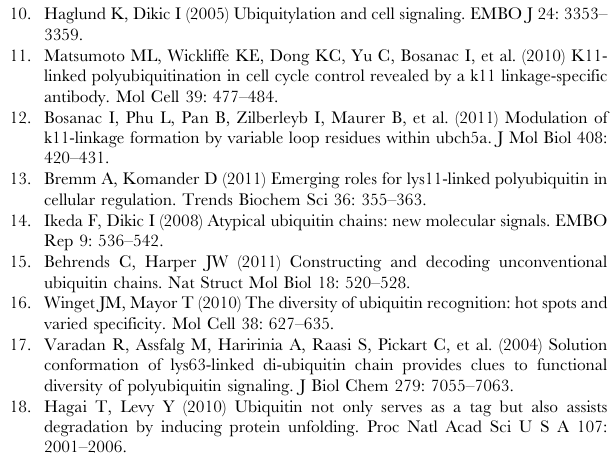
linked diUbs. Figure S12 Conformational distribution of K63-diUb based on the order parameter similar to smFRET measurement. It is difficult to monitor the conformational space of K63-diUb via this order parameter. However, the populations of open and compact states are estimated to be 24% and 76%, respectively. This is quantitatively consistent with the smFRET data. Despite of this, it is better to investigate the conformational dynamics of diUb with more than dye pairs because one-dimensional conformational distribution or free energy profile have been suggested to be not sufficient to describe the multi-state landscape of many proteins. Figure S13 Evidence that intermediate states are possibly hidden on the one-dimensional conforma- tional distribution or free energy profiles but can be detected by multi-dimensional free energy profiles. Note that the data is from the simulation of K48-diUb model. Figure S14 Functional landscape of K33-diUb. K33-diUb only can form the similar conformation to the compact state of K6 with I36–I44 interface (PDB 2XK5) but also is able to sample the similar conformation of the compact state of K11 with I36-I36 interface (PDB 3NOB). Figure S15 Convergence analysis of single independent simulation. As a typical simulation, one of the MD trajectories of K48-diUb model was chosen to show the result. The trajectory